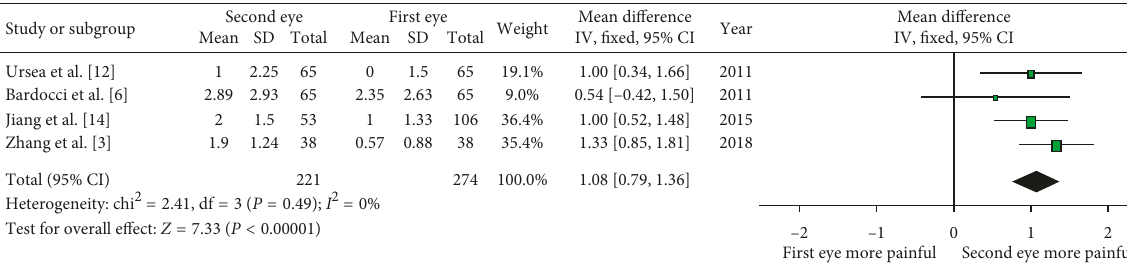
Figure 3: Forest plot comparing the pain scores under topical anesthesia.